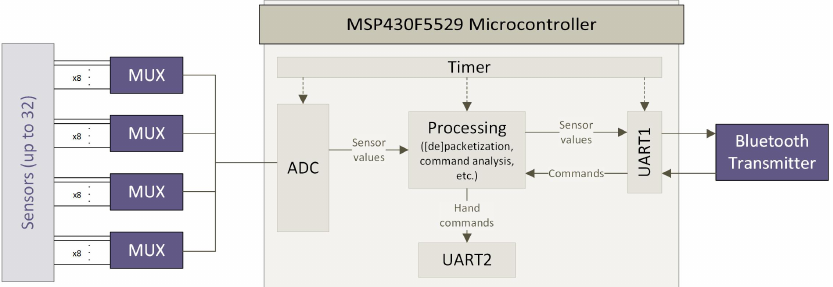
Figure 2. Functional block representation of the analog-to-digital converter (ADC) board for the surface electromyography (sEMG) sensors (reproduced with permission from [15]).